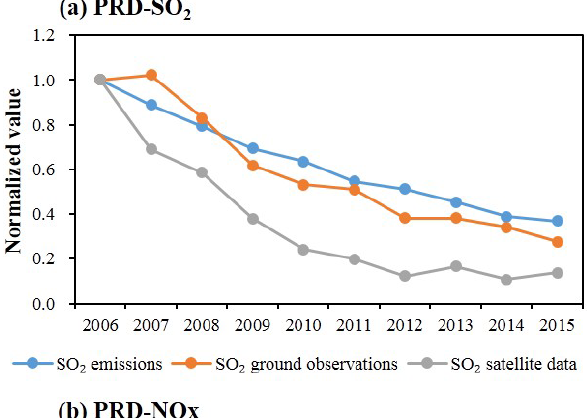
tively. From 2007 to 2011, NO 2 column concentration de- creased by 16 % in PRD but increased by 16 % in